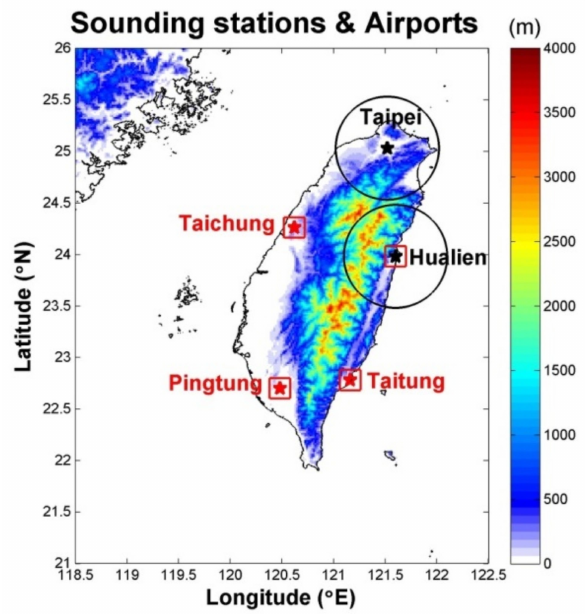
Figure 1. Highly distributed terrain in Taiwan; black stars represent sounding stations and red squares represent airport